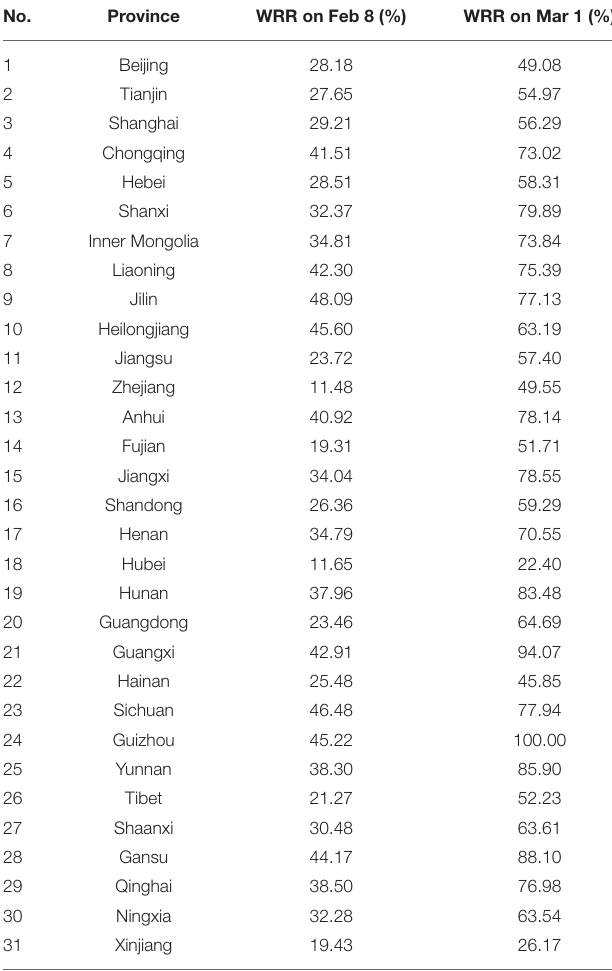
TABLE 3 | WRR of 31 provinces on February 8, 2020 and March 1,